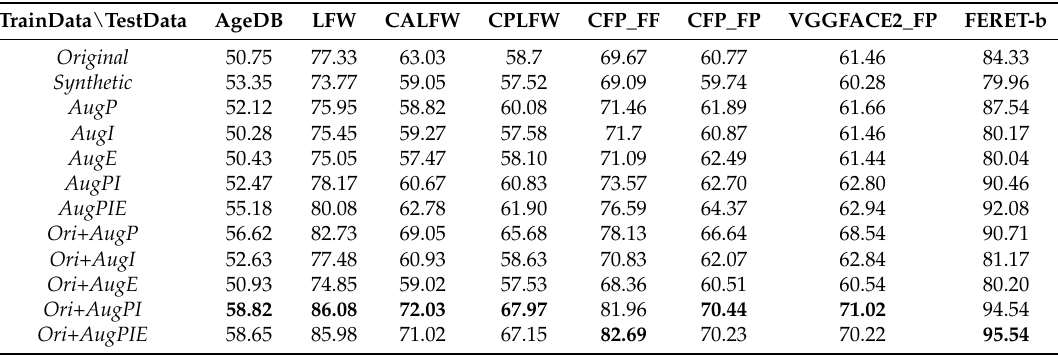
Table 1. Face verification rates (%) of the first implementation of our proposed method on different benchmark datasets when different enriched face images from the CelebA database were used for training. The best result on each dataset is shown in bold.